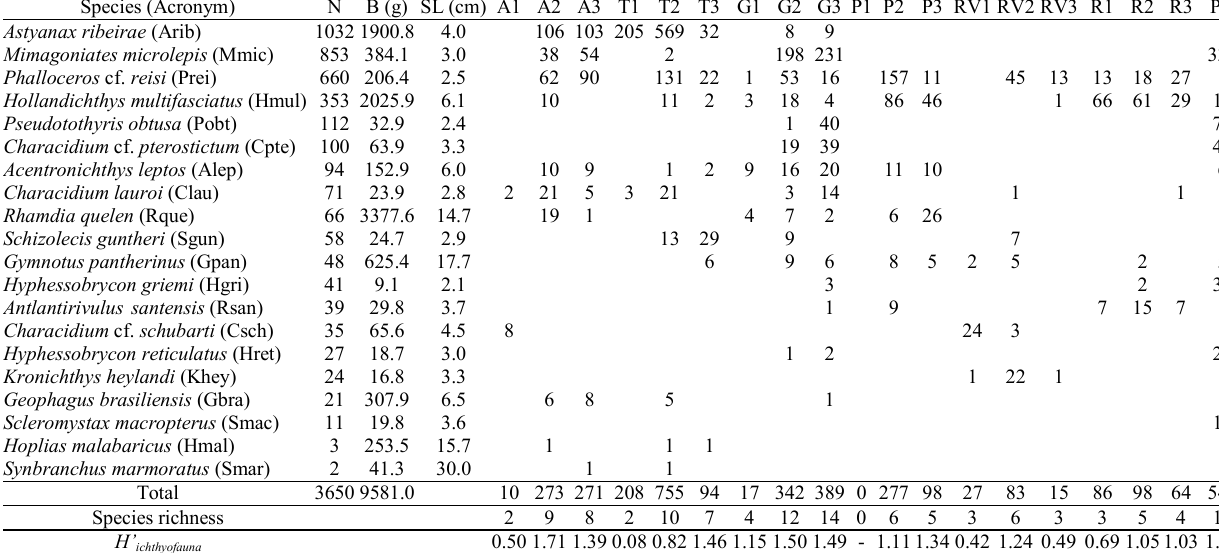
Table 2. Total number of individuals (N), biomass (B), and average standard length (SL) of fish species from all sites, species richness, Shannon diversity index considering the ichthyofauna ( H’ ) of each sampled site in Jureia-Itatins Ecological ichthyofauna Station, between April 2009 and February 2010. Streams: Antas (A), Tetequera (T), Grajaúna (G), “Ponte 2” (P), rio Verde (RV), “Riacho 1”, and rio Preto (PR). Stretches: upper (1), middle (2), and lower (3). Site-specific columns represent the number of individuals for each